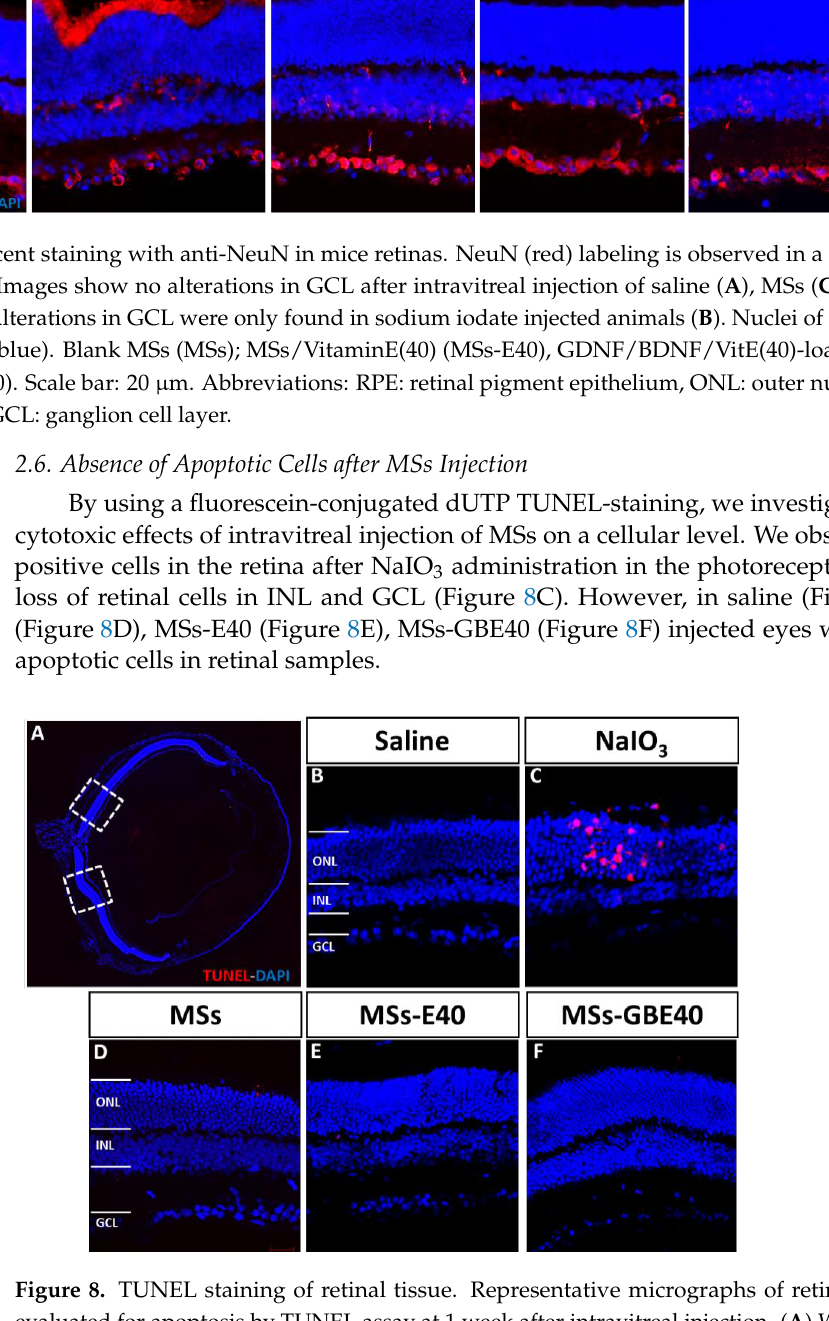
Figure 8. TUNEL staining of retinal tissue. Representative micrographs of retina sections were